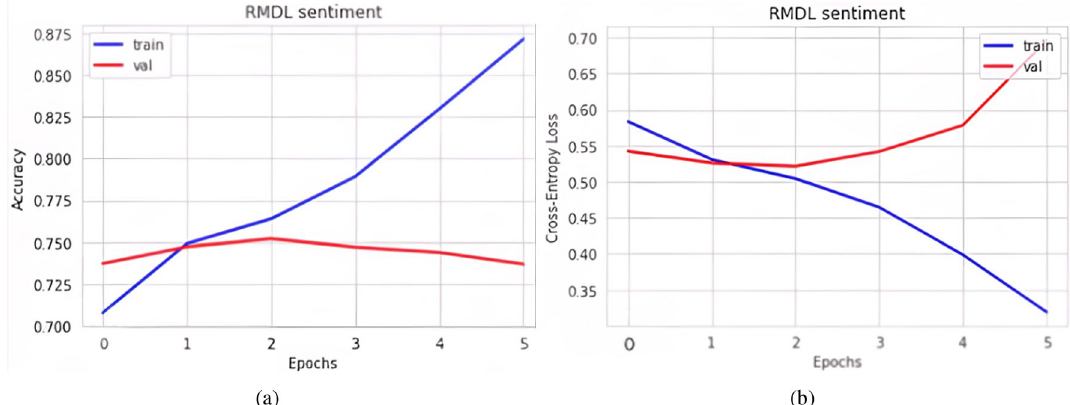
Figure 13. FastText plus RMDL ( a ) Model accuracy FastText plus RMDL ( b ) Model loss FastText plus RMDL.